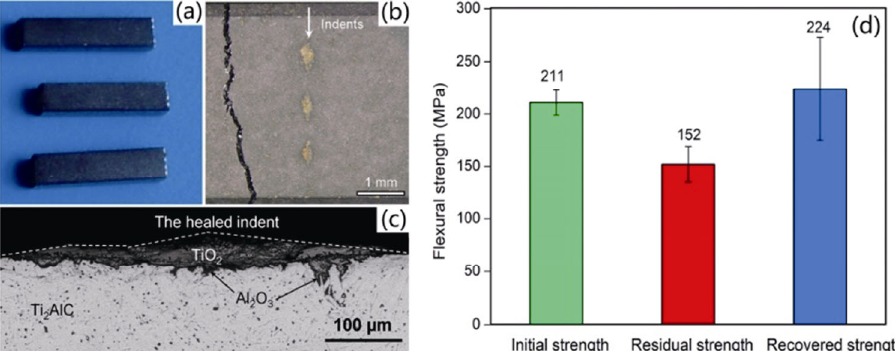
Fig. 4 Optical images of (a) the damaged samples after three-point bending test, which were fractured along the Knoop indents; (b) the healed sample after testing; (c) cross-sectional back-scattered SEM for the healed indent as shown in (b); (d) flexural strength of the virginal, damaged, and healed Ti 2 AlC samples. Error bars represent the standard deviation. Reproduced with permission from Ref. [83], © Elsevier Ltd.